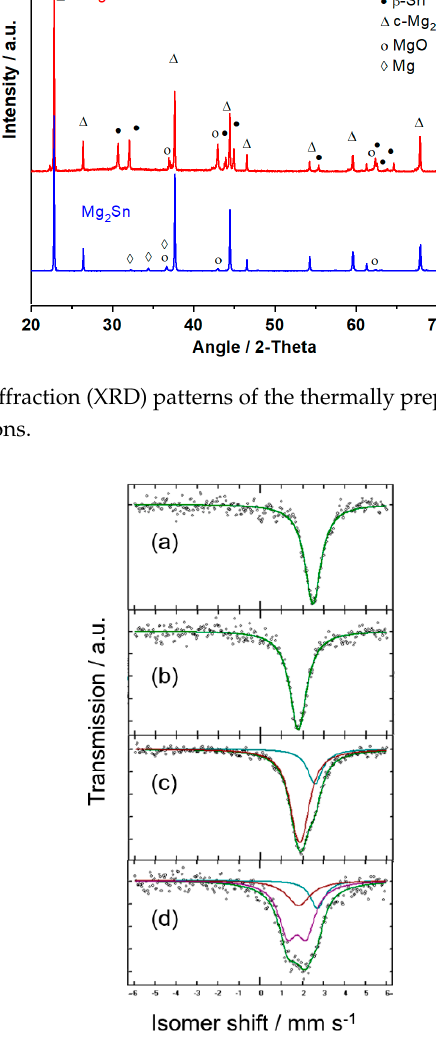
Figure 2. 119 Sn Mössbauer spectra of ( a ) tin microparticles, and thermally prepared samples with ( b ) Mg 2 Sn and ( c ) MgSn nominal compositions. ( d ) micro-Sn electrode after discharge in Mg half-cell to a Mg 0.4 Sn nominal composition.